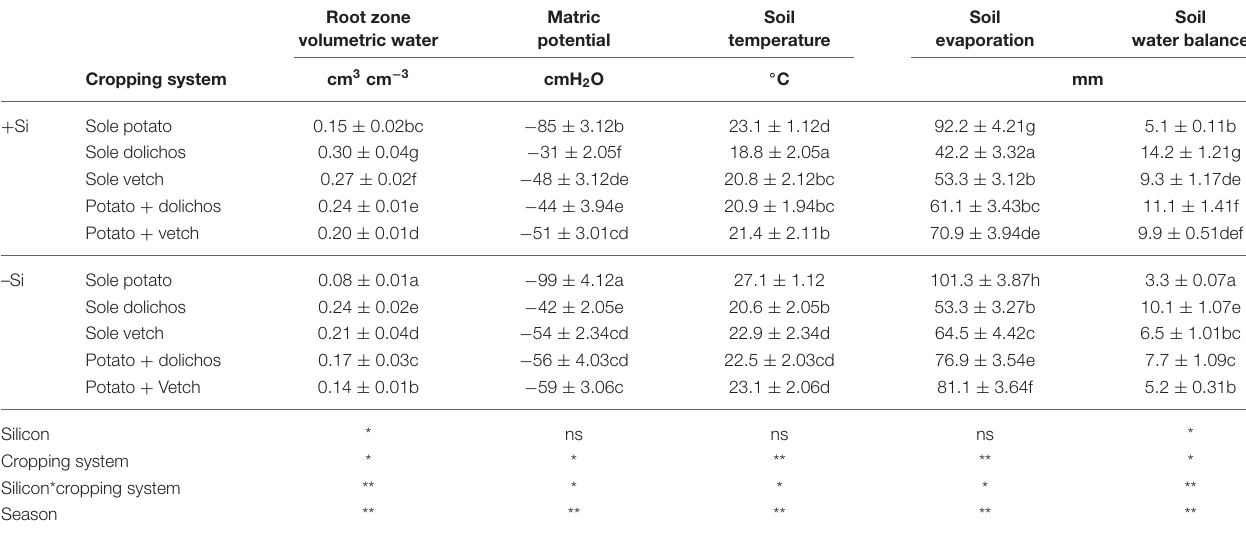
TABLE 2 | Effect of silicon application and legume intercropping on soil, soil temperature, soil evaporation, and soil water